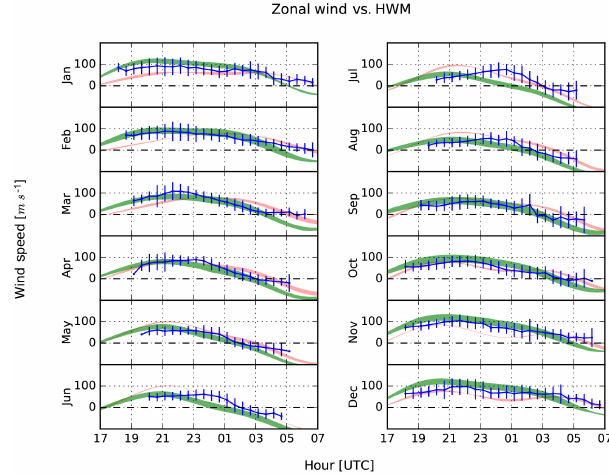
Figure 5. Monthly averages of zonal winds from January 2014 until February 2016 (blue). Airglow-weighted model results from HWM07 (red) and HWM14 (green). Positive values are